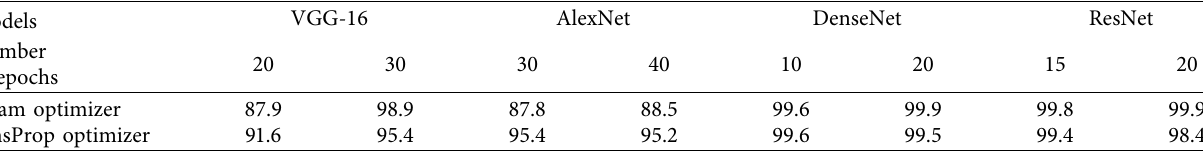
Figure 4: VGG16-Net architecture. Table 2: Accuracy of VGG-16, AlexNet, DenseNet, and ResNet using Adam and RmsProp.